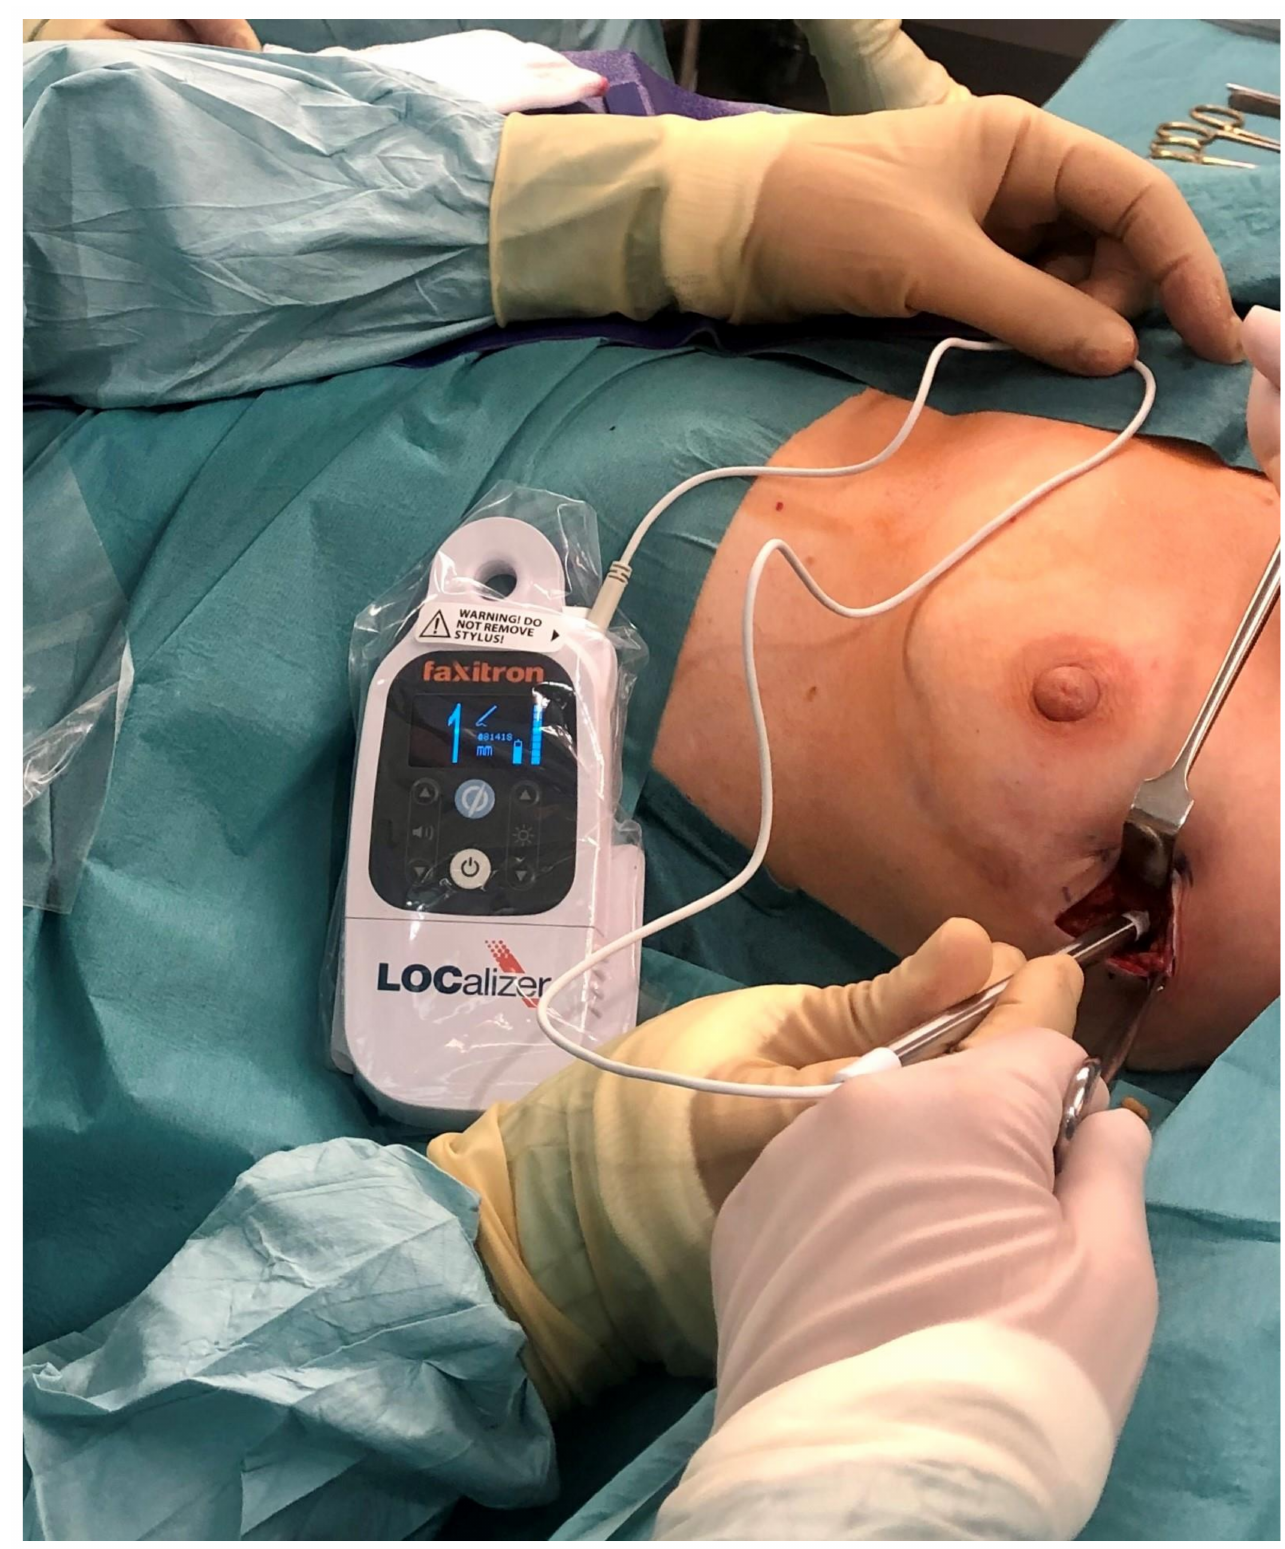
Figure 2. LOCalizer™ handheld reader device being used intra-operatively to locate the RFID tag implanted at the tumour site in the axillary tail of the left breast during surgery. RFID: radio-frequency